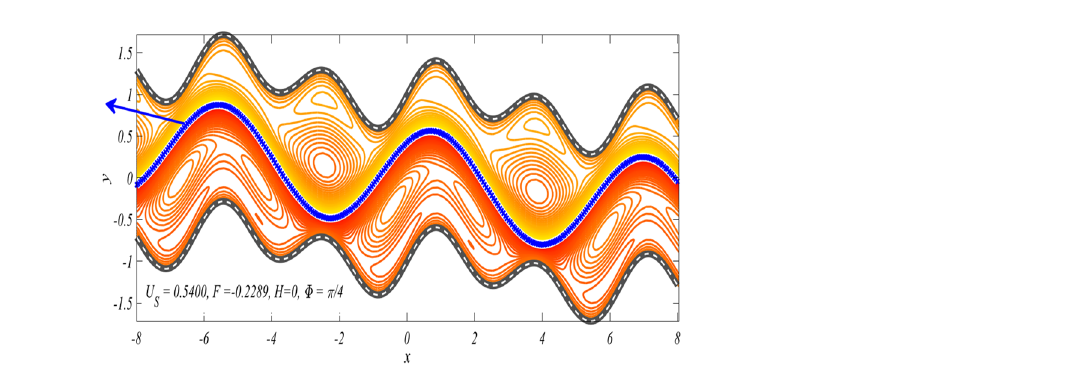
Figure 15. Impact of magnetic field on